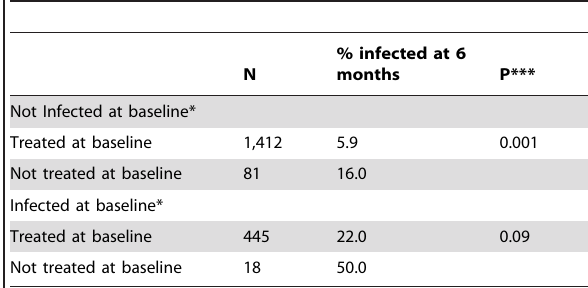
Table 3. Interaction of baseline infection and treatment, and infection at 6 months**.